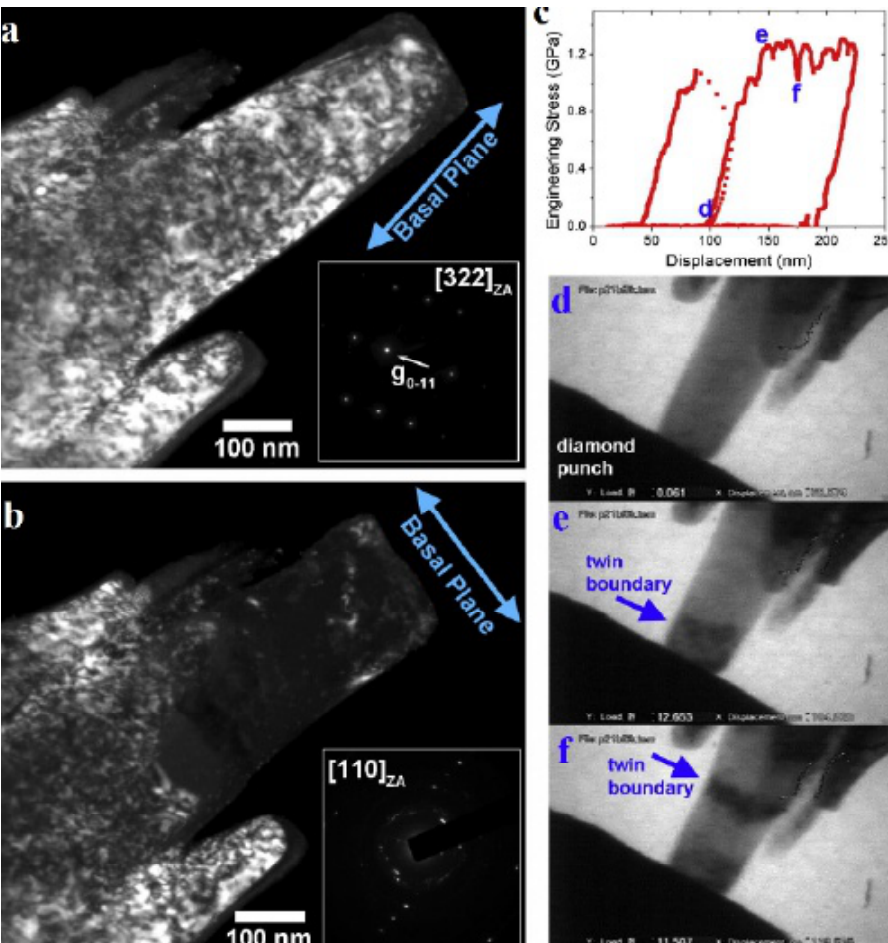
Fig. 33. Example of extension twinning in a 200 nm pure Mg pillar. (a) Dark-field image of the pillar before the test. (b) Dark-field image of the pillar after the test, showing that the pillar now has a different orientation from the base of the pillar. Inset shows the diffraction pattern of the twinned pillar, revealing that the basal plane is now roughly perpendicular to the loading axis. (c) Engineering stress- displacement curve of the pillar compression. The large load drop seen at 75 nm displacement is a result of a large dislocation burst through the pillar. (d-f) frames from the in situ video, corresponding to marked points in (c). At point (d) the pillar is relatively defect free (d) after the large burst of dislocations. At point (e) a twin is nucleated, with the boundary shown in (e). At point (f) the twin boundary has moved through the pillar and is seen in (f). The final result is a completely twinned pillar (b). Reprinted with permission from Ye J, Mishra RK, Sachdev AK, Minor AM. 2011. In situ TEM compression testing of Mg and Mg-0.2 wt.% Ce single crystals.